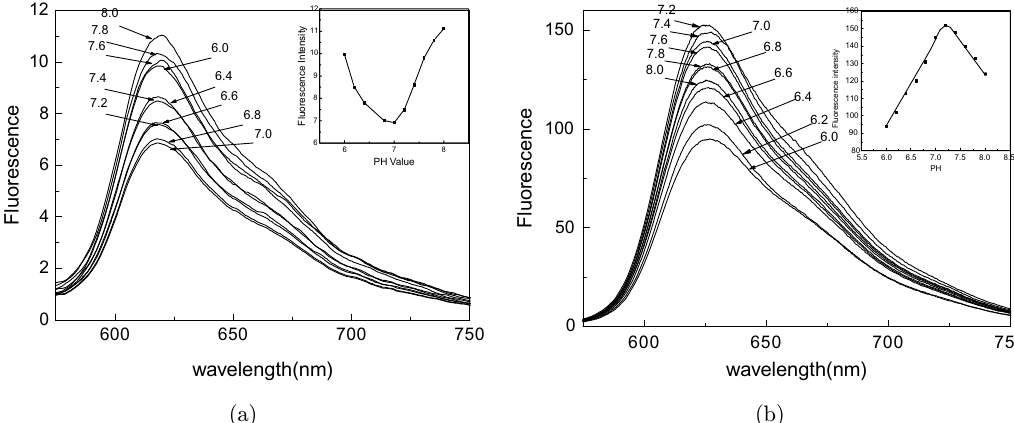
Fig. 11. Fluorescence spectra of HB in PBS (a) or in liposome (b) with a series of pH values. Insets: plots of peak °uorescence intensity to pH value.